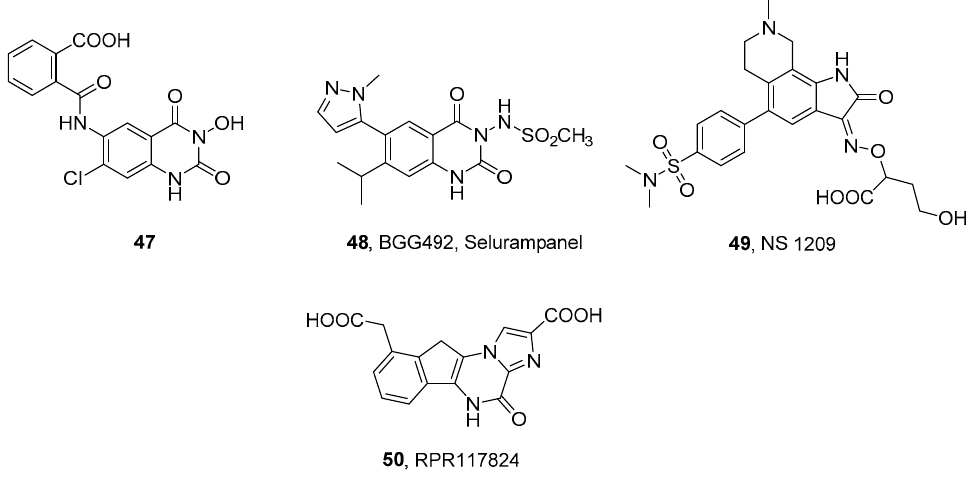
Figure 7. Structurally dissimilar AMPAR/KAR antagonists. Table 7. Receptor binding affinity of selected structurally dissimilar antagonists at native and recombinant homomeric iGluRs, determined in radioligand binding assays (all values in µ M). Native iGluRs Recombinant Homomeric iGluRs cmpd AMPA KA